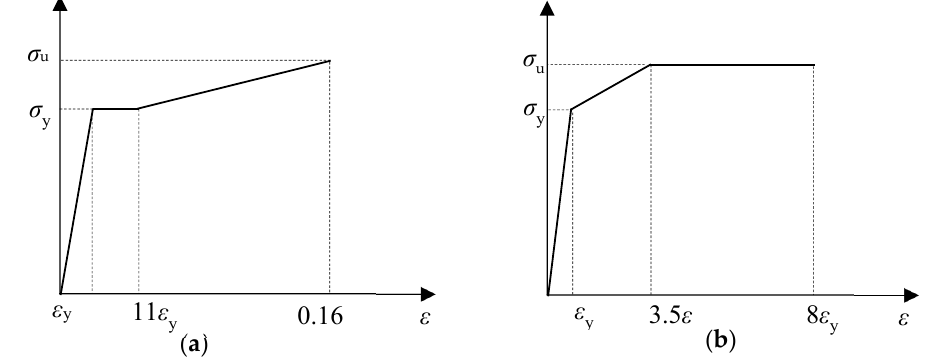
Figure 14. Steel principal structure curves. ( a ) Steel Q235B; ( b ) High-strength bolts. Both the column base and beam end of the specimen model were hinged (Figure 15a).